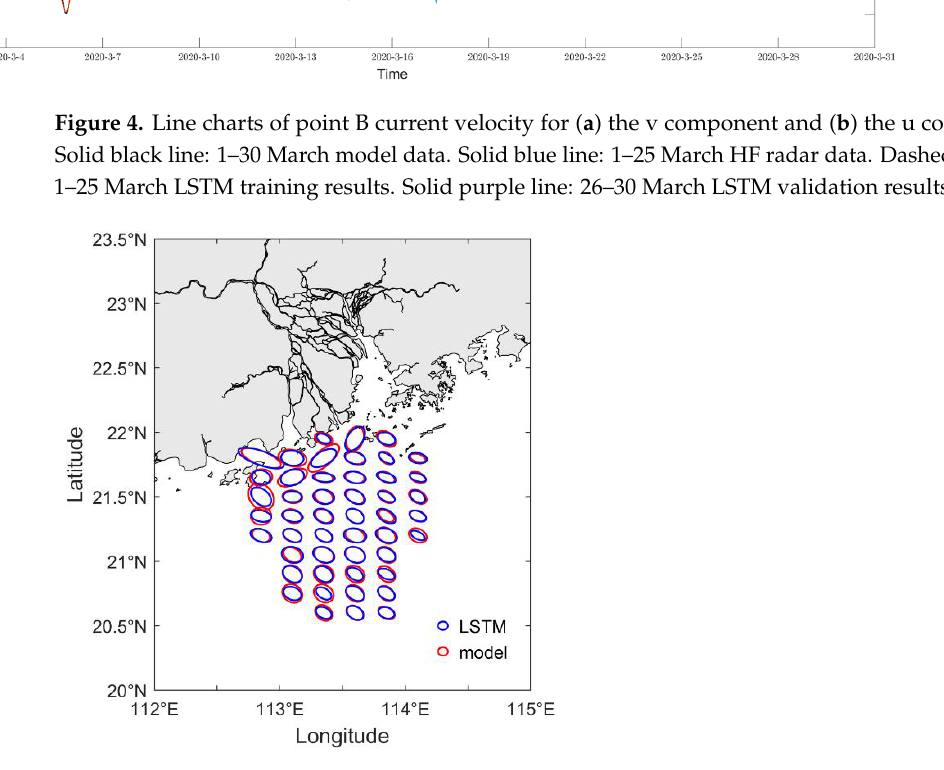
Figure 5. EOF ellipses calculated from LSTM validation results (blue) and model (red) within the radar observation area. Table 1. Domain-averaged PCCs and RMSEs in areas A, B, and C.